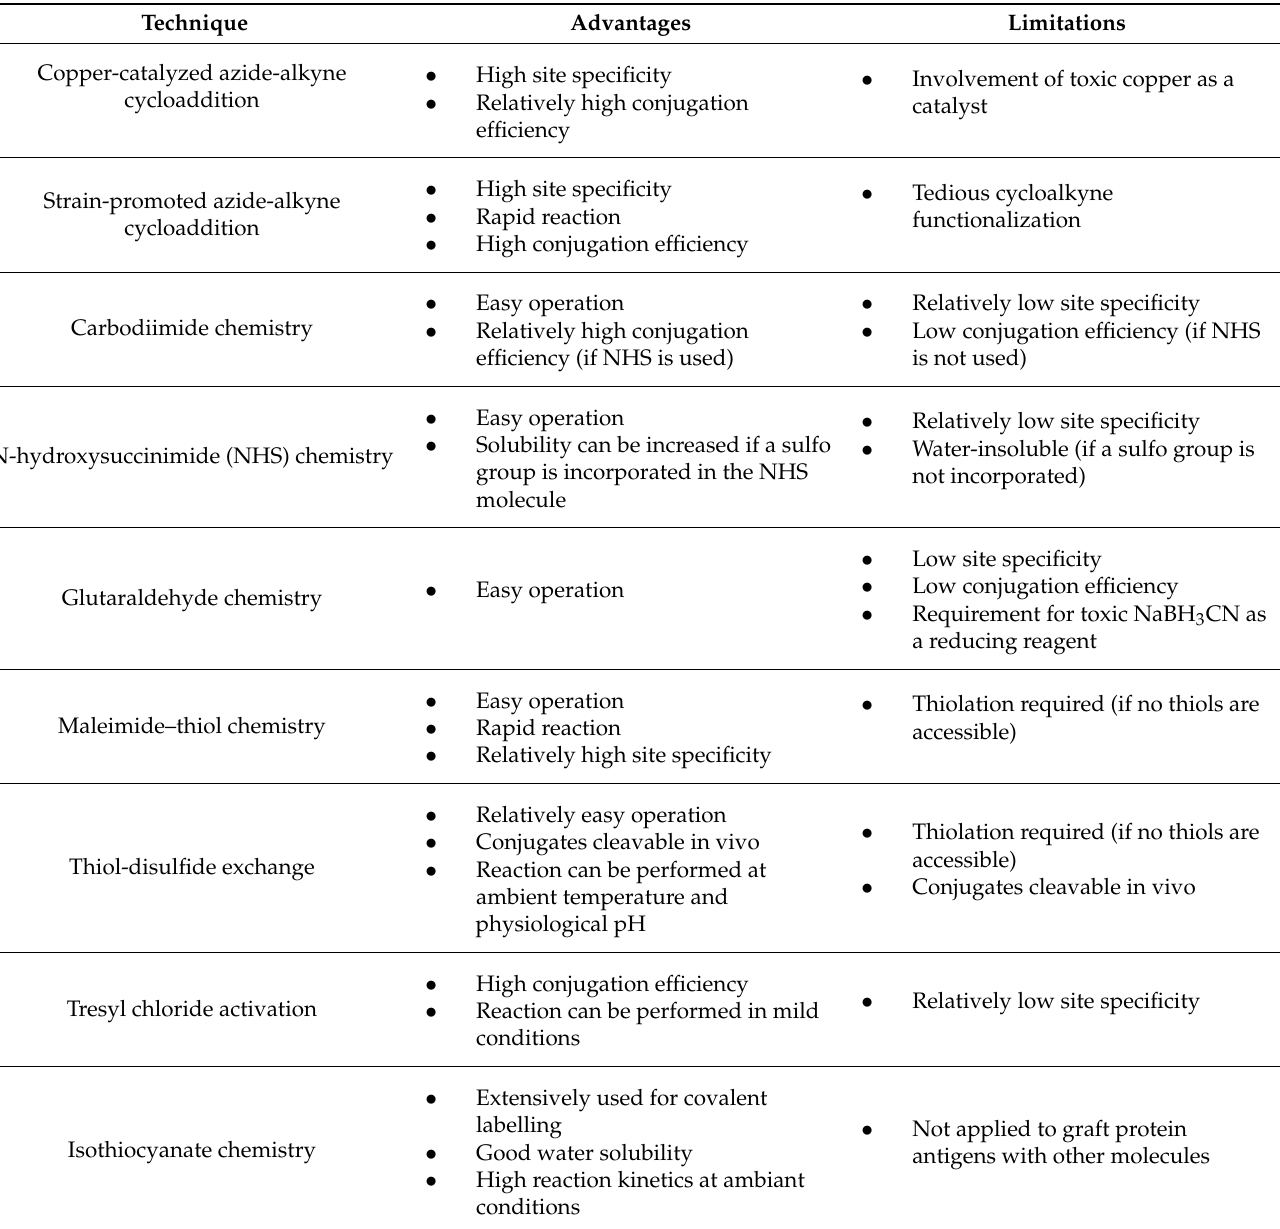
Table 1. Advantages and limitations of protein conjugation